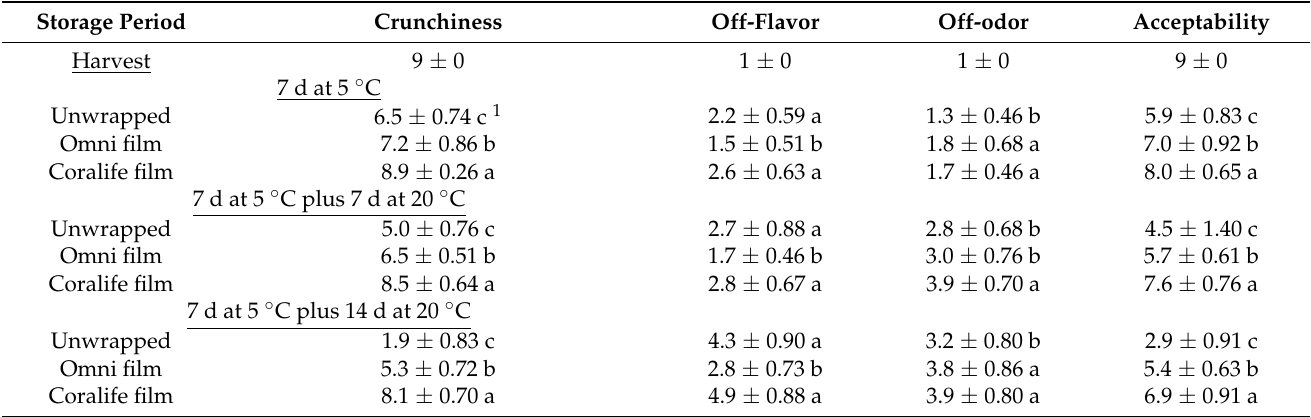
Table 5. Sensory evaluation of ‘Simeto’ mandarins after seven days at 5 ◦ C and 85–90% RH, plus seven or fourteen days at 20 ◦ C and 55–60%